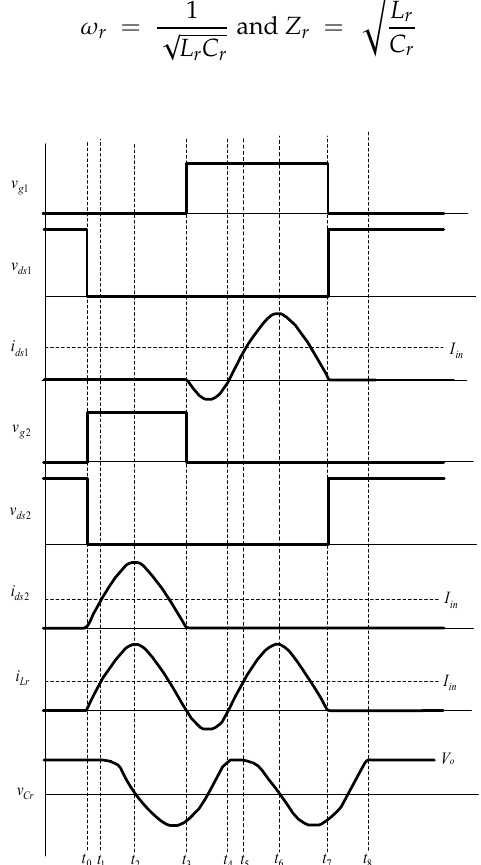
Figure 2. Illustrated waveforms relevant to the proposed soft switching boost converter operating.